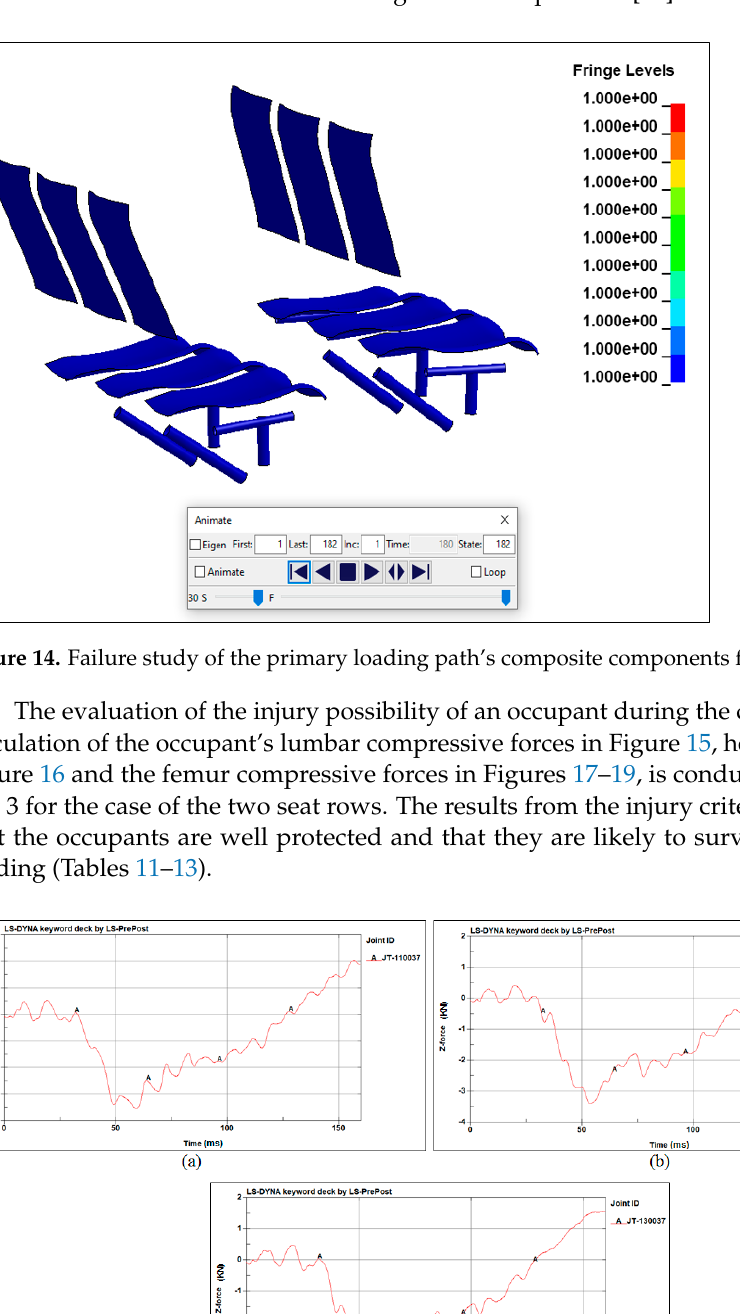
Figure 15. Test 1: Lumbar compressive force (KN) vs. time (ms) of ( a ) Dummy 1, ( b ) Dummy 2 and ( c ) Dummy 3.